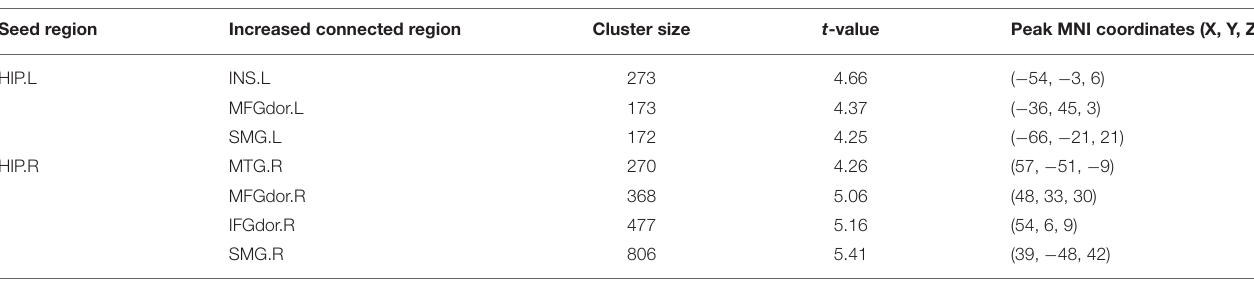
TABLE 3 | FC analysis